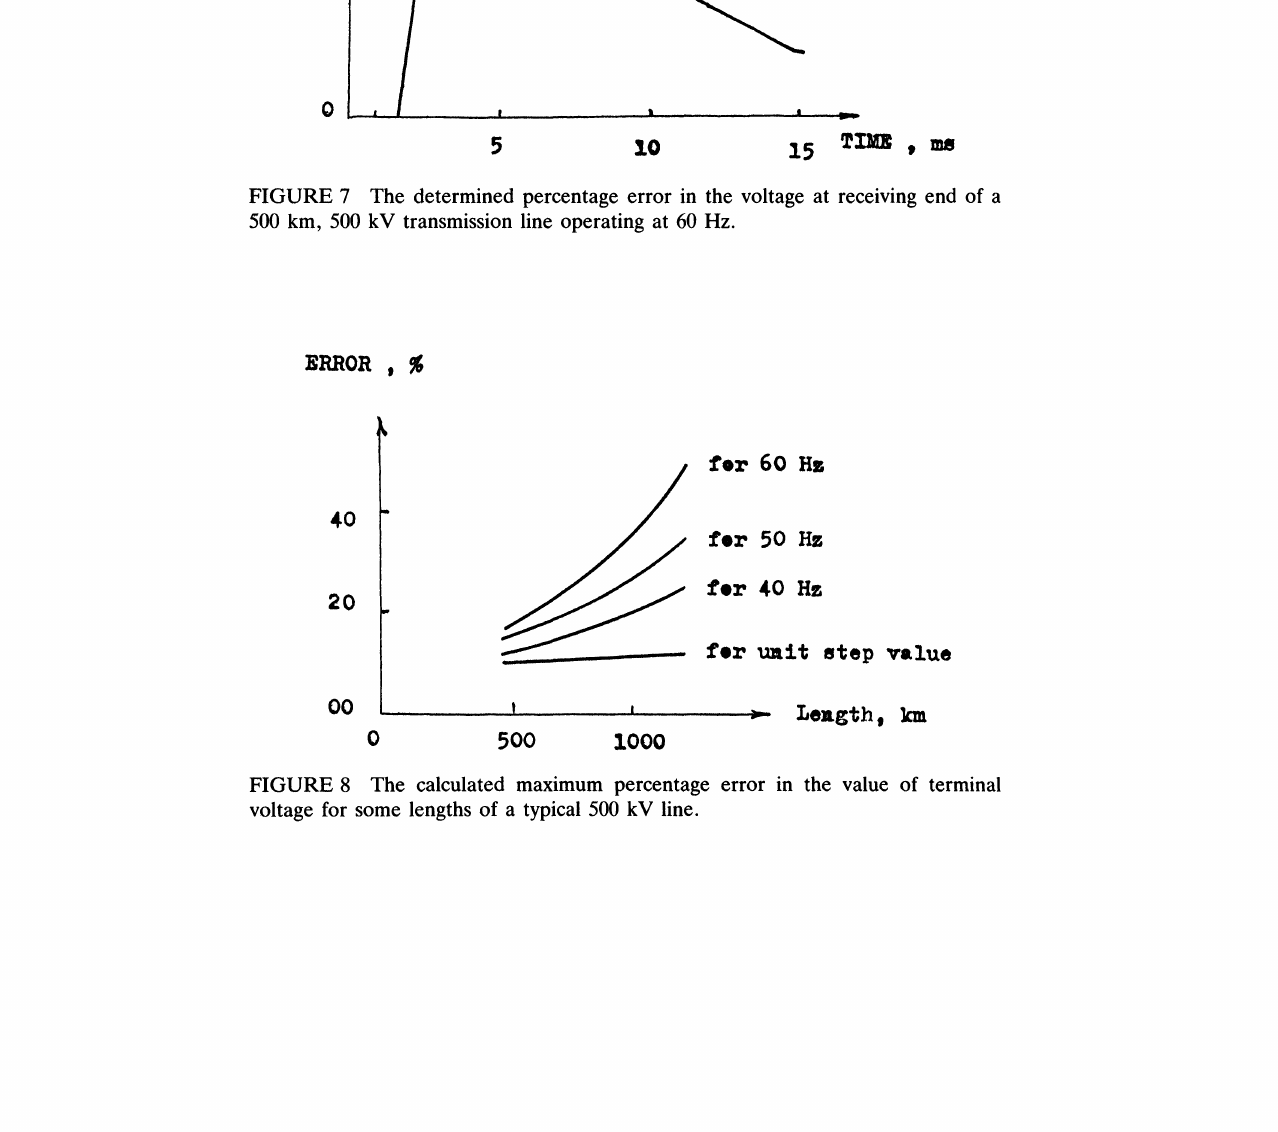
FIGURE 7 The determined percentage error in the voltage at receiving end of a 500 km, 500 kV transmission line operating at 60 Hz.